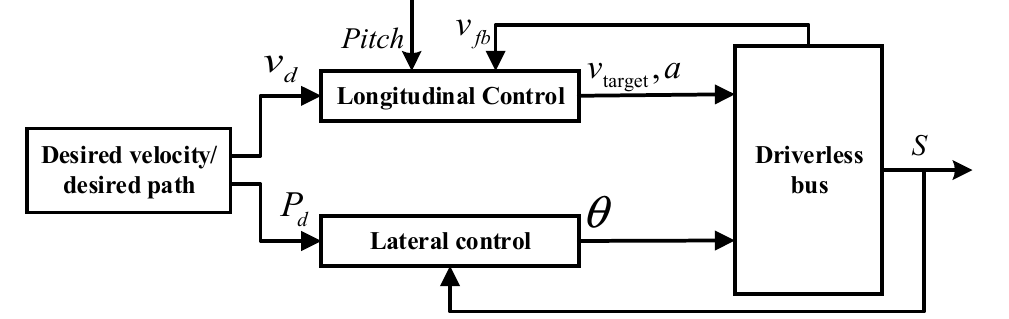
Figure 1. The structure of the path-tracking controller.